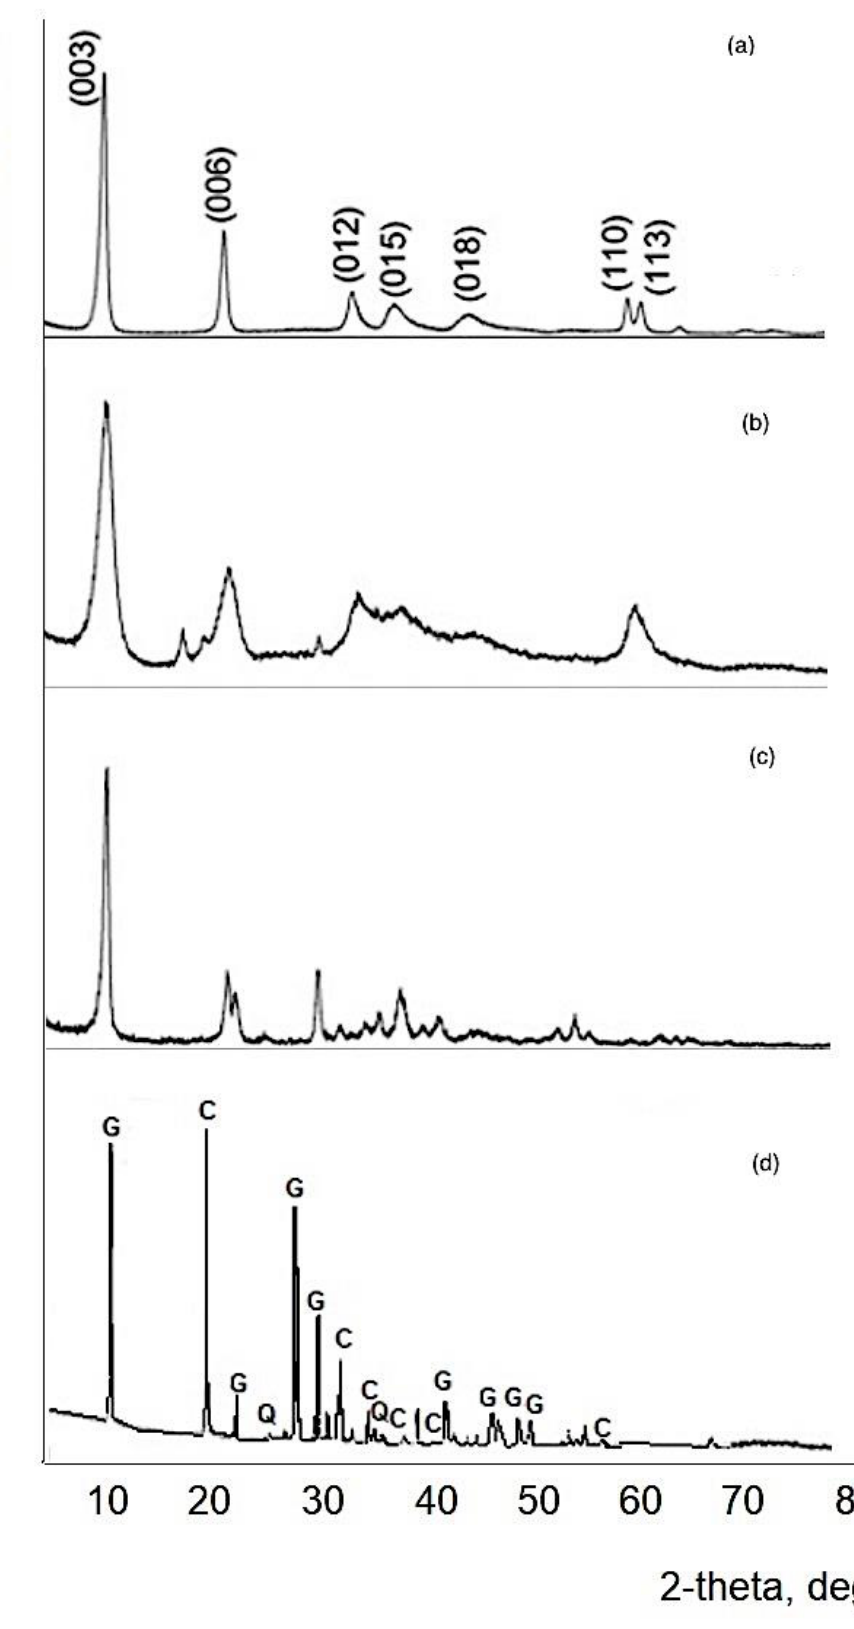
Figure 1. XRD pattern for the prepared materials (C = calcite, Q = quartz, G = gypsum) ( a ) CMgAl- LDH; ( b ) CaMgAl-LDH; ( c ) CaAl-LDH; ( d ) specimen.